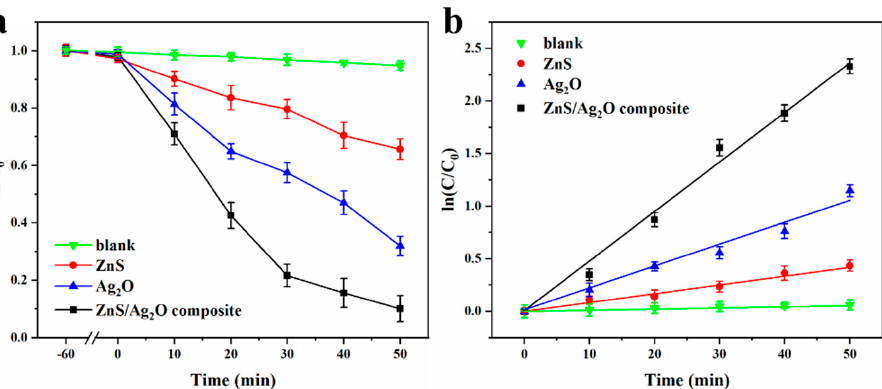
Figure 7. ( a ) Photocatalytic degradation profiles of MB at 664 nm as a function of time. ( b ) Linear fittings of degrading kinetics under different catalytic conditions.